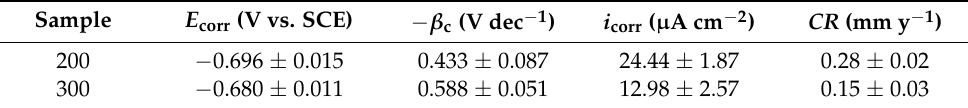
Figure 6. Potentiodynamic polarization curves obtained after 24 h of immersion in the tested solution. Table 5. Potentiodynamic polarization parameters in the tested solution obtained after 24 h of im- mersion.